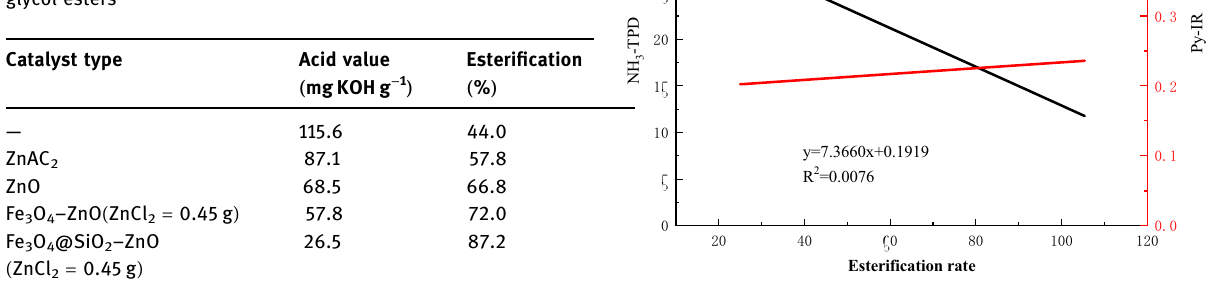
Table 1: The e ff ect of di ff erent catalysts on the reaction of rosin glycol esters a